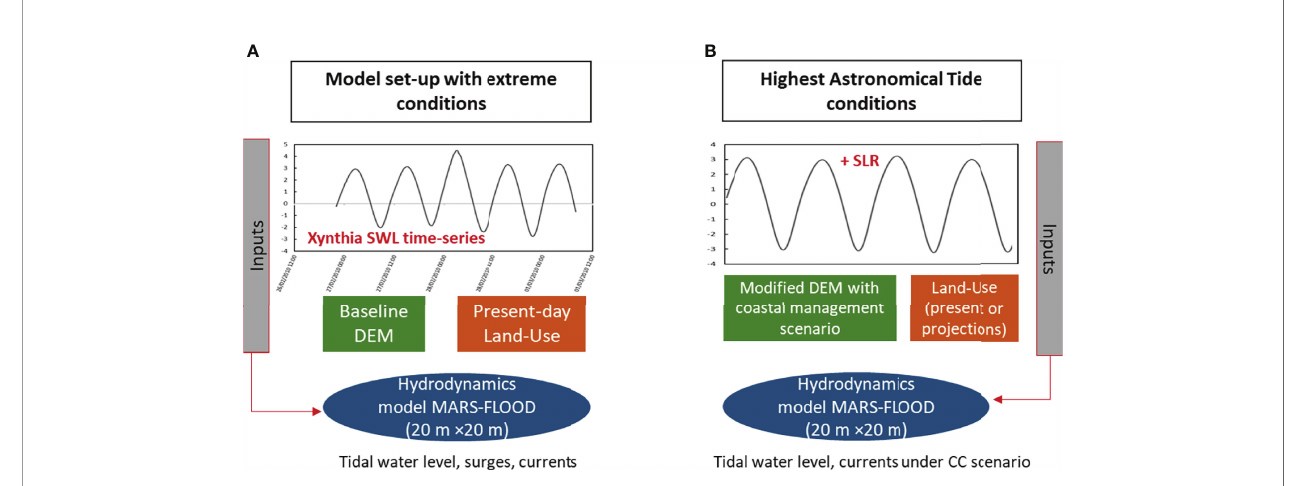
FIGURE 2 | Model set-up: (A) under stormy conditions, using storm Xynthia Still Water Level time series and the baseline DEM; (B) for highest astronomical tide conditions, using the modi fi ed DEM.